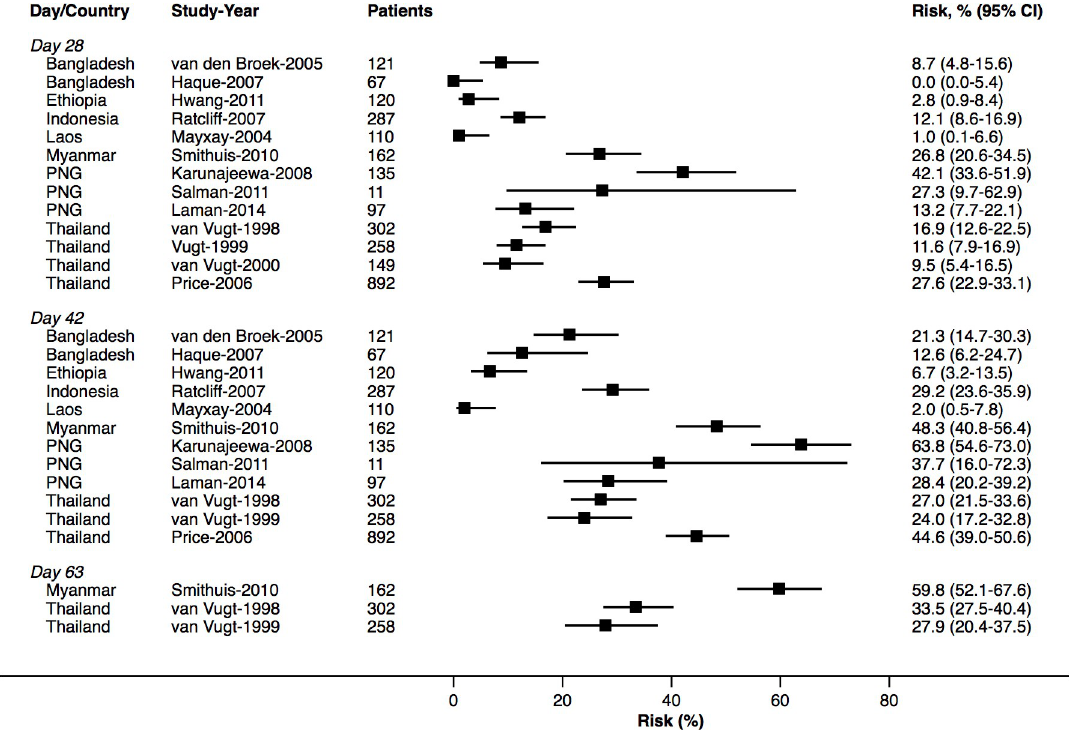
Fig 3. Cumulative risk (Kaplan–Meier analysis) of P . vivax parasitaemia after P . falciparum infection by study for AL. AL, artemether-lumefantrine.